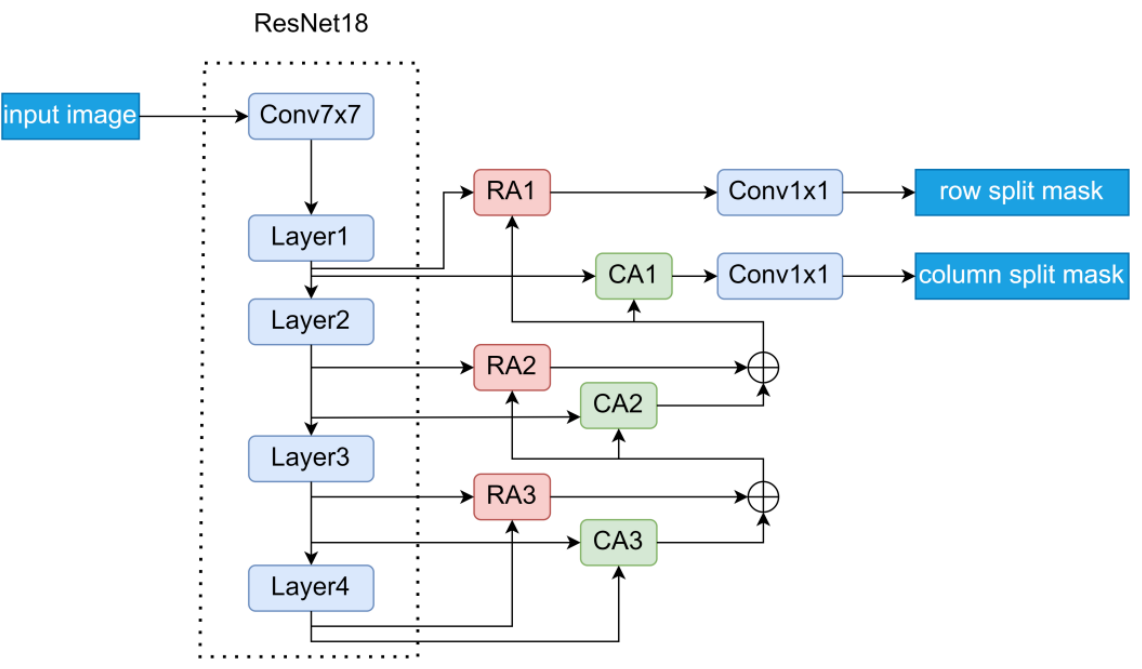
Figure 1. RCANet network structure.